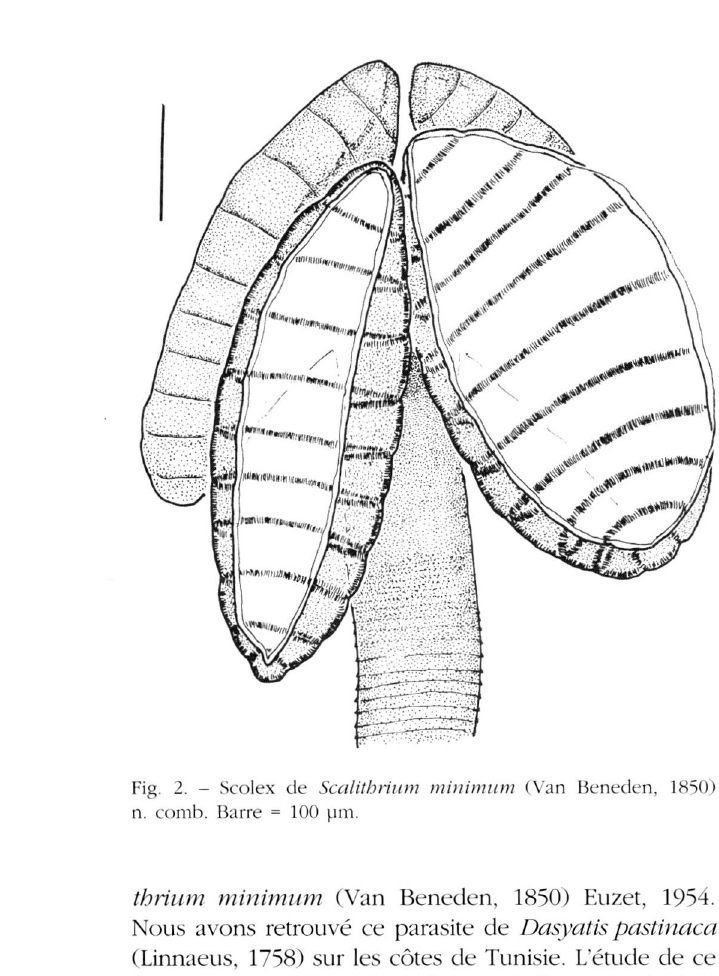
Fig. 2. - Scolex de Scalithrium minimum (Van Beneden, 1850) n. comb. Barre = 100 µm.